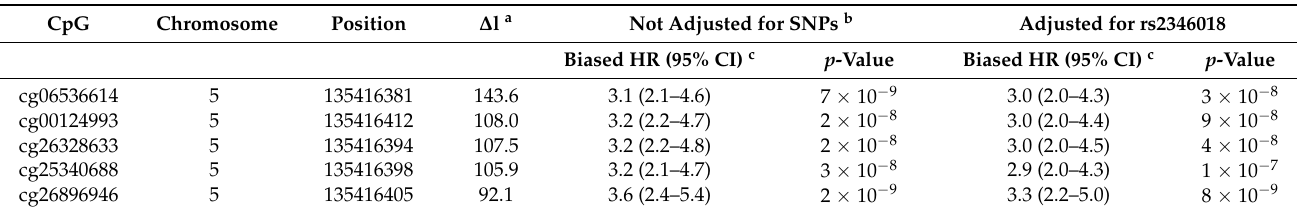
Table 5. Associations with breast cancer risk after adjustment for rs2346018 carrier probabilities a